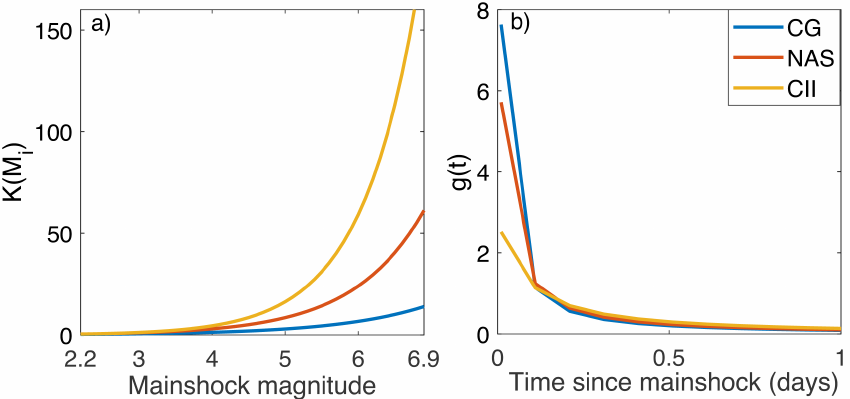
Figure 8. ( a ) The number of events triggered by an earthquake of magnitude M i at CG (blue), NAS (orange) and CII (brown), respectively. ( b ) The temporal distribution of triggered